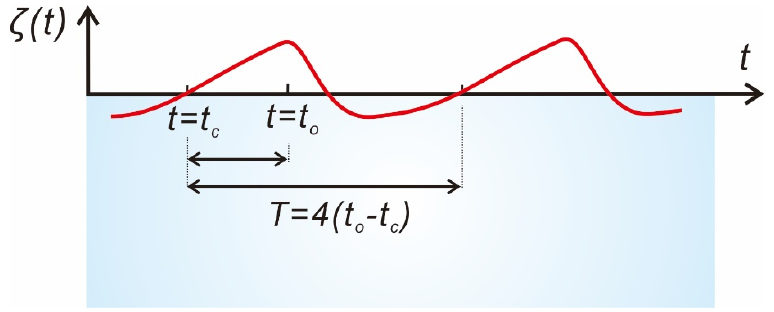
Figure 8. Schematic sketch of geometrical model for the wave period.